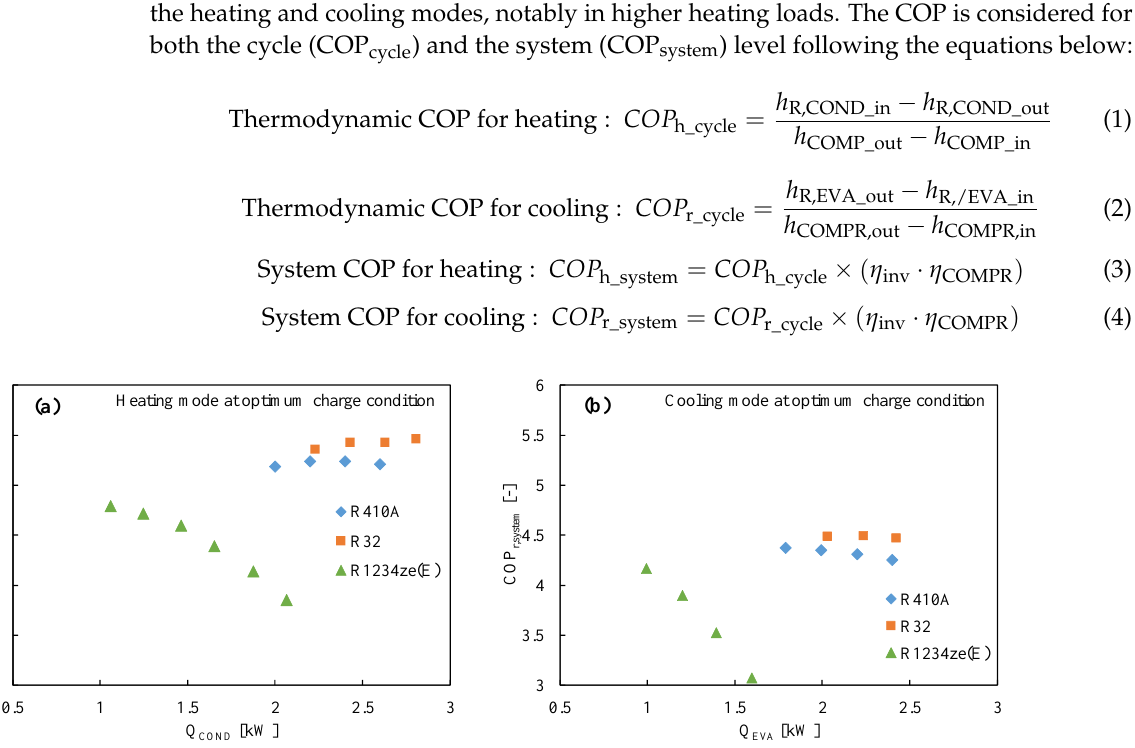
Figure 2. The coefficient of performance of the R1234ze(E), R410A, and R32 refrigerants in a drop-in experiment in ( a ) the heating mode and ( b ) the cooling mode [76].